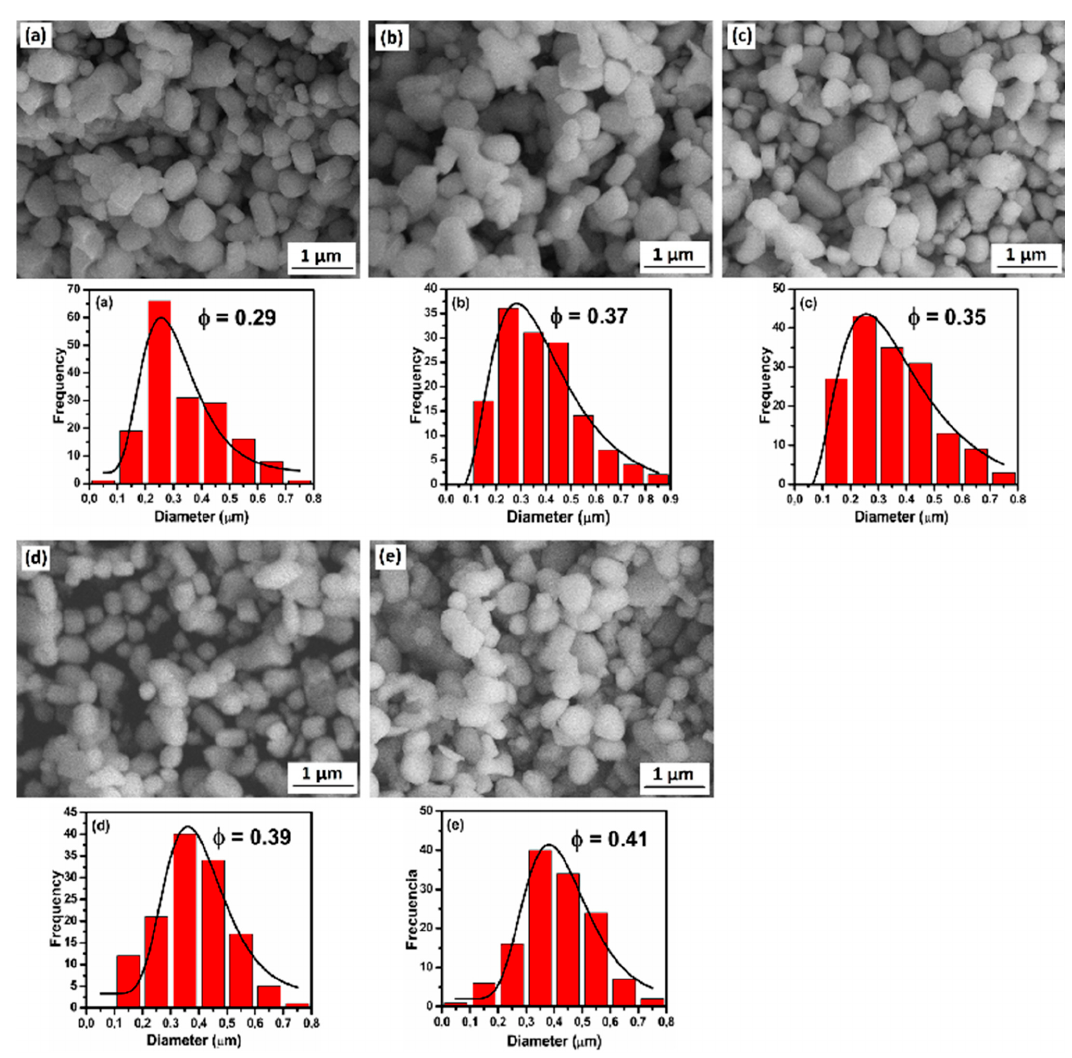
Figure 3. SEM micrographs of mechanochemical synthesized of Nd 1.1 Fe 10 CoTi particles nitrogenized for ( a ) 0 h, ( b ) 3 h, ( c ) 6 h, ( d ) 9 h and ( e ) 12